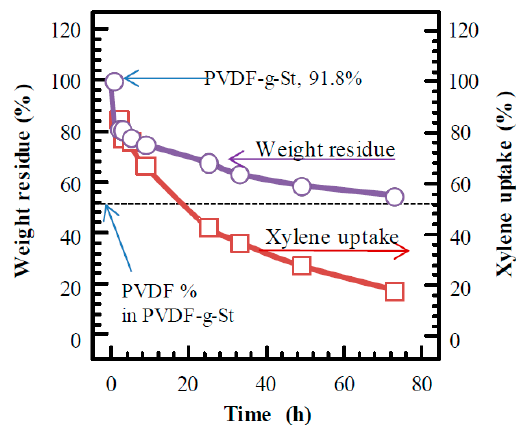
Figure 1. Weight residue and xylene uptake of the residual PVDF– g –St film (initial degree of grafting, 91.8%) under xylene extraction at 138 ° C as a function of time. The dotted line means the weight percentage of PVDF backbone in the starting PVDF– g –St film, 52.0% .